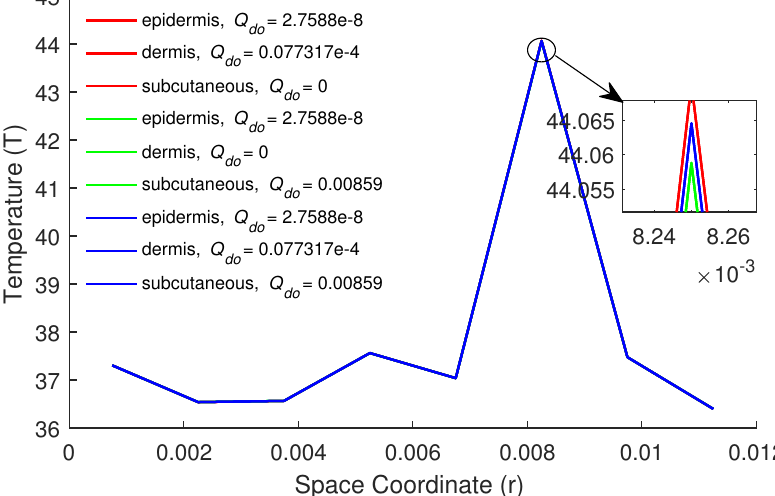
Figure 9. Temperature distributions for different values of Q do in first kind